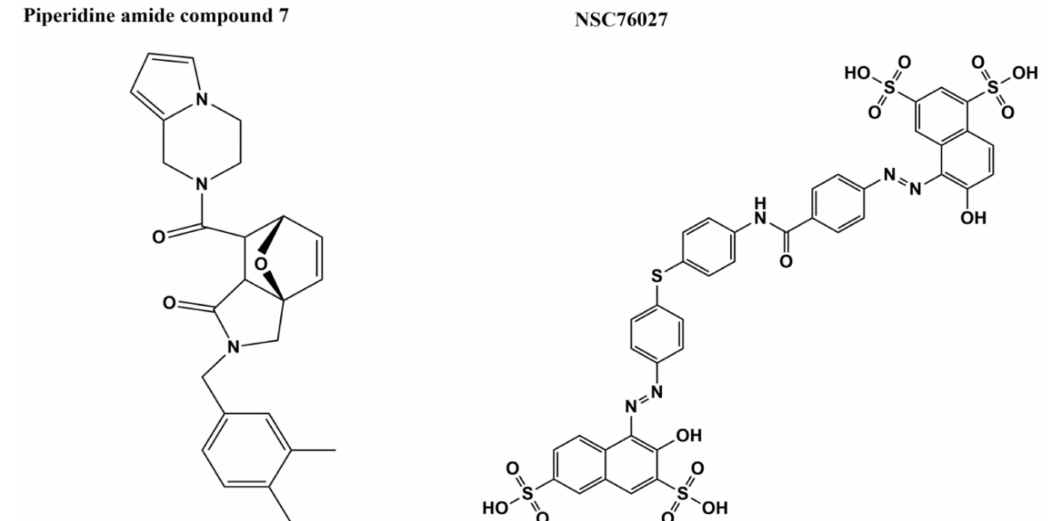
Figure 9. Bacterial topoisomerase I inhibitors identified by in silico screening—piperidine amide compound 7 [95] and NSC76027